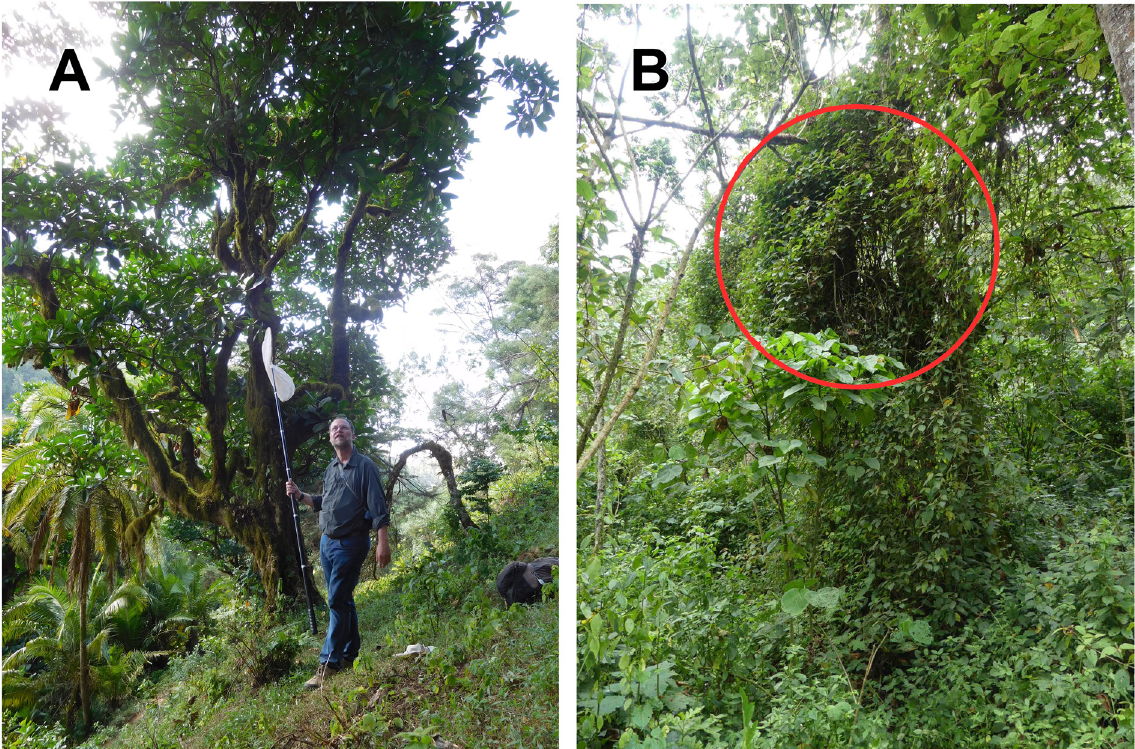
Fig. 1. Localities where Afrosyrphus schmuttereri sp. nov. was collected. A . Sampling point in the trail to Iyale ( Taita Hills, Kenya). B . Sampling point in the Ruhija Section of the Bwindi Impenetrable National Park (Uganda). Red circle indicates exactly where the flower flies were